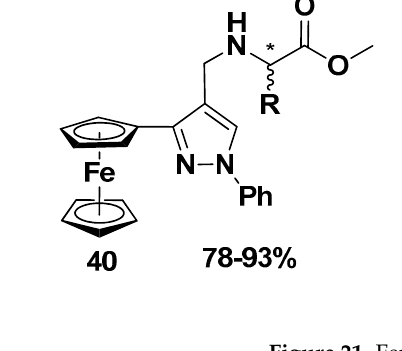
Figure 21. Ferrocene-modified pyrazole amino acids methyl esters, R = H (glycine) ( a ); Me (alanine- DL, L, D) ( b ); CH 2 Ph (phenyl alanine-DL, L, D) ( c ); Et (valine-DL, L, D) ( d ); CH 2 OH (serine-DL, L) ( e ); 4-HOC 6 H 4 CH 2 (tyrosine-DL, L, D) ( f ); CH 2 -3-indole (tryptophan-DL, L) ( g ); proline (DL, L) ( h ); and Et ( α -amino butyric acid-DL, L, D) ( i ) [72].